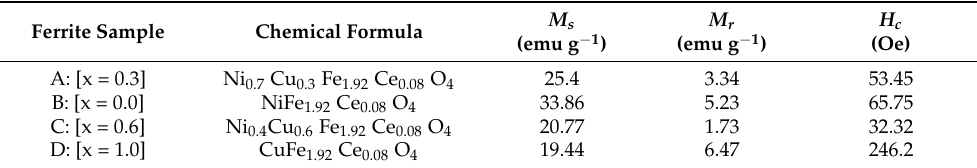
Table 1. Magnetic values of Ni 1-x Cu x Fe 1.92 Ce 0.08 O 4 ferrite particles. Ferrite